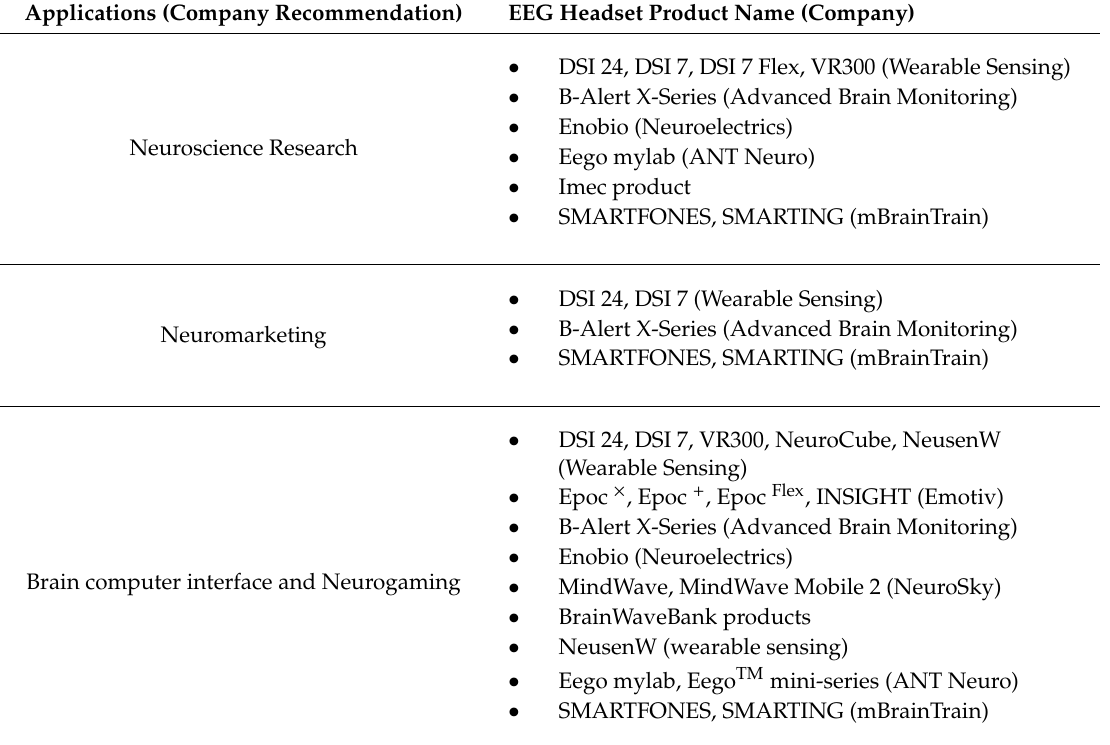
Table 1 indicates the applications that each EEG Headset has been used in, according to the producing company’s reports. Table 1. Recommended EEG application by manufactured company. Applications (Company